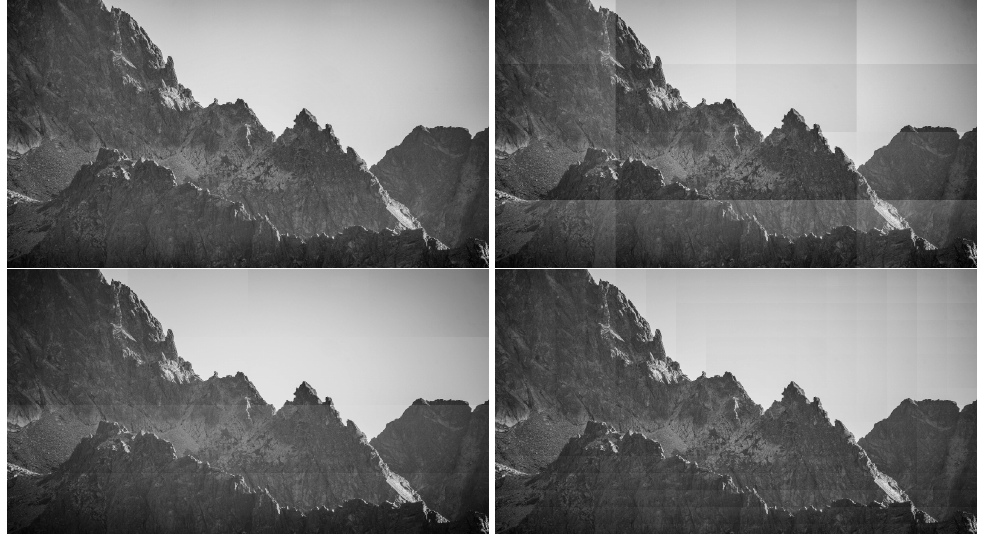
Figure 16. Comparison of different methods of generating the output image: bilinear interpolation ( top left ), no interpolation with 4 × 4 grid of blocks ( top right ), mean CDF with 4 × 4 grid of blocks ( bottom left ) and mean CDF with 16 × 16 grid of blocks ( bottom right ). Bilinear interpolation provides the best results with almost no visible artefacts.